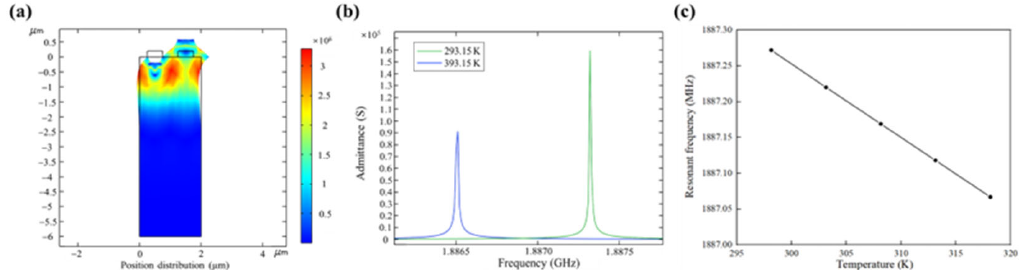
Figure 6. Finite element temperature simulation analysis of SAW. ( a ) Stress diagram of finite element simulation model affected by temperature; ( b ) comparison of admittance curves before and after temperature change; ( c ) the relation curve between temperature and resonant frequency of SAW.